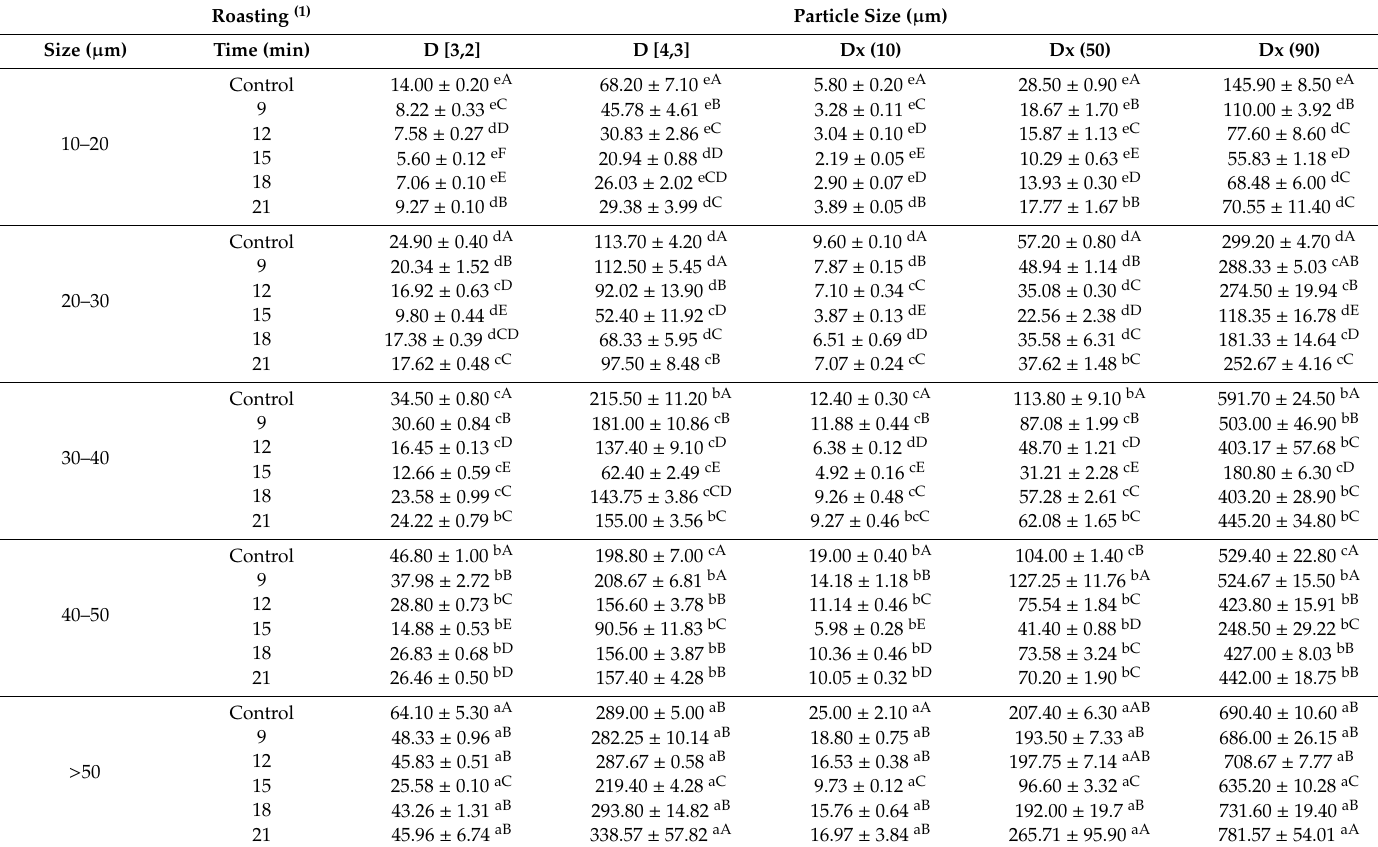
Table 2. Particle size of dried ginseng powder with various roasting time